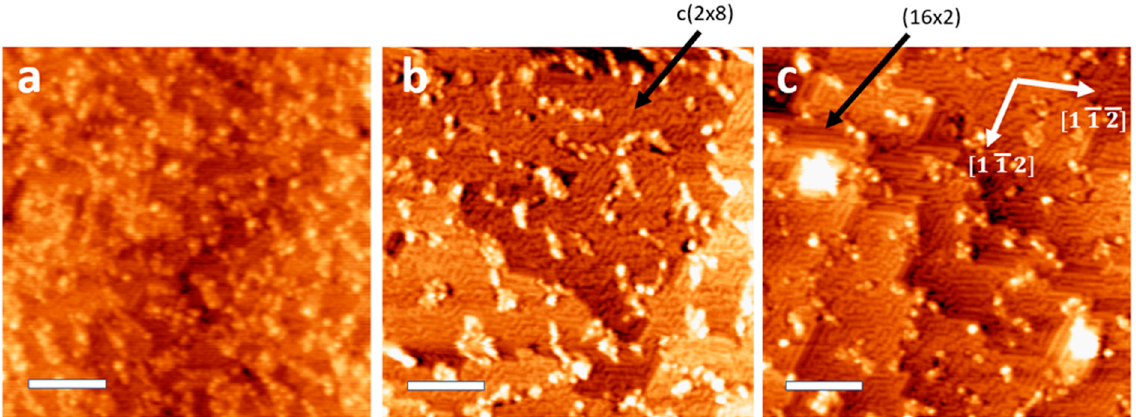
Figure 2. STM topographical images of a bare Ge (110) sample with ( a ) 14 cleaning cycles, fluence 1.6 × 10 17 cm − 2 ; ( b ) 23 cleaning cycles, fluence 2.6 × 10 17 cm − 2 ; and ( c ) 33 cleaning cycles, fluence 3.7 × 10 17 cm − 2 , performed in a Ag-coated sample holder using 100 eV Ar + . Imaging parameters 0.5 nA, 2 V tip bias. Scale bars: 30 nm.